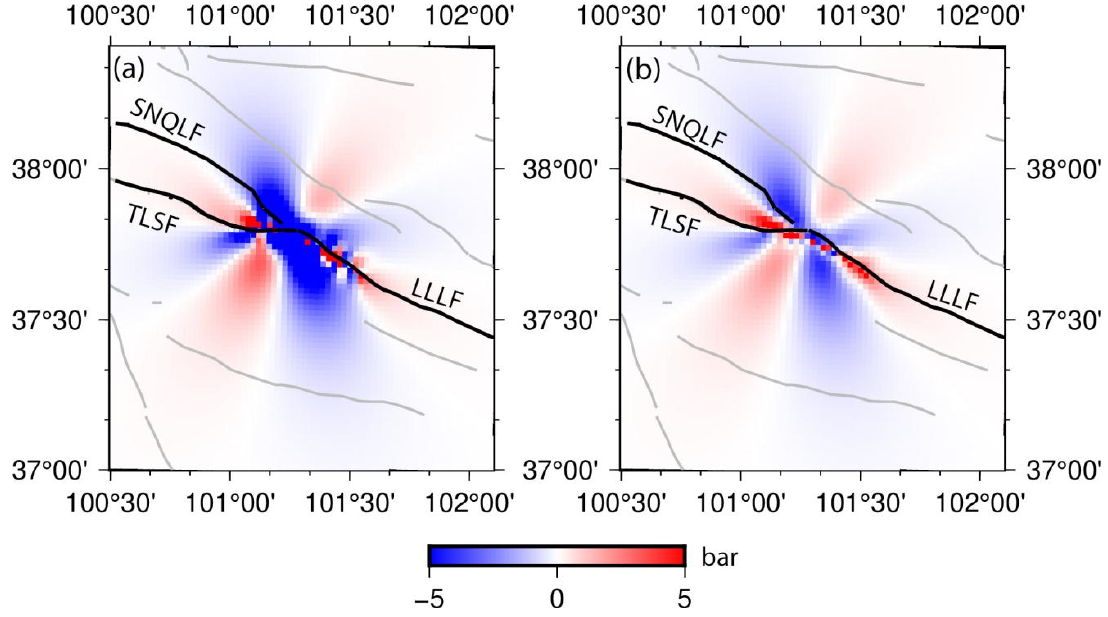
Figure 11. Static Coulomb stress change in surrounding region caused by the 2022 Menyuan earth- quake. Static Coulomb stress change at a depth of 5 km. ( a ) Static Coulomb stress change at a depth of 10 km. ( b ) TLSF: Tuolaishan fault; LLLF: Lenglongling fault; SNQLF: Sunan–Qilian fault.